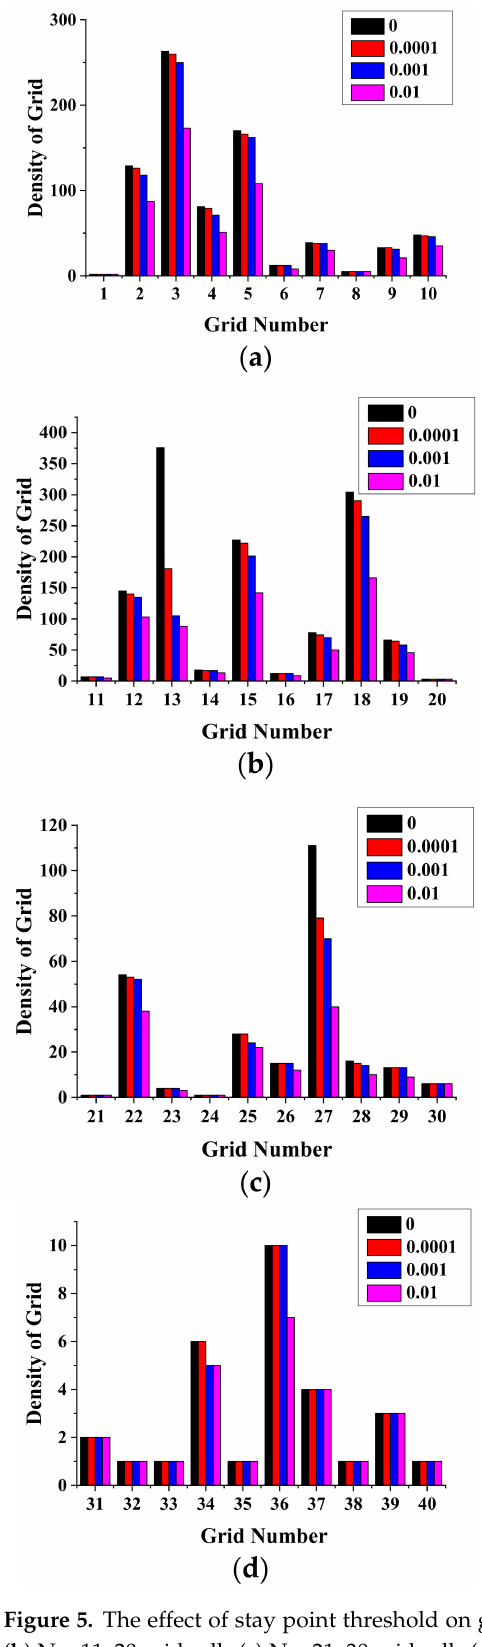
Figure 5. The effect of stay point threshold on grid cell density. Results of ( a ) No. 1–10 grid cells ( b ) No. 11–20 grid cells ( c ) No. 21–30 grid cells ( d ) No. 21–30 grid